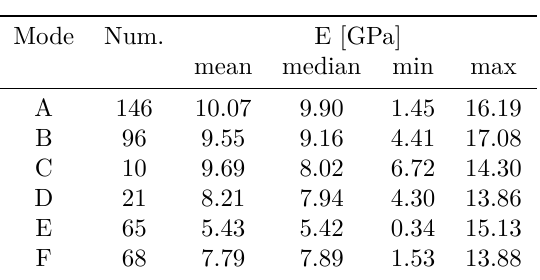
Table 4. Young’s moduli from tensile test according to failure mode.